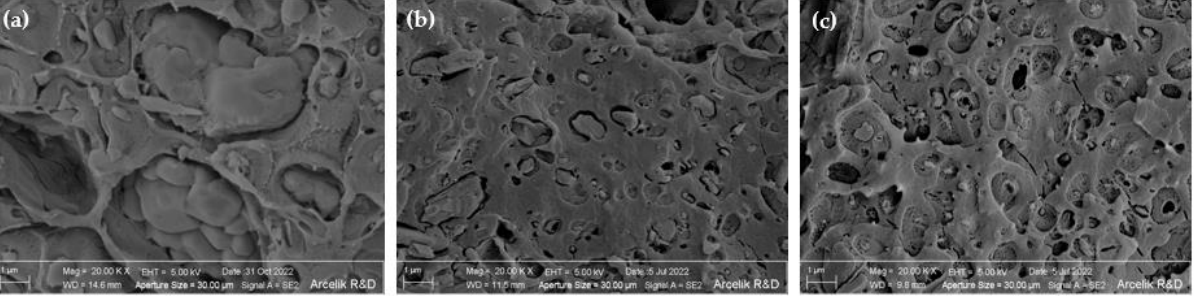
Figure 4. SEM images of impact fracture surfaces: ( a ) PA-GF-25FR; ( b ) PLA-GF-24FR-1PCDI; ( c ) PLA-GF-24FR- CE (the scale bar is 1 μm).